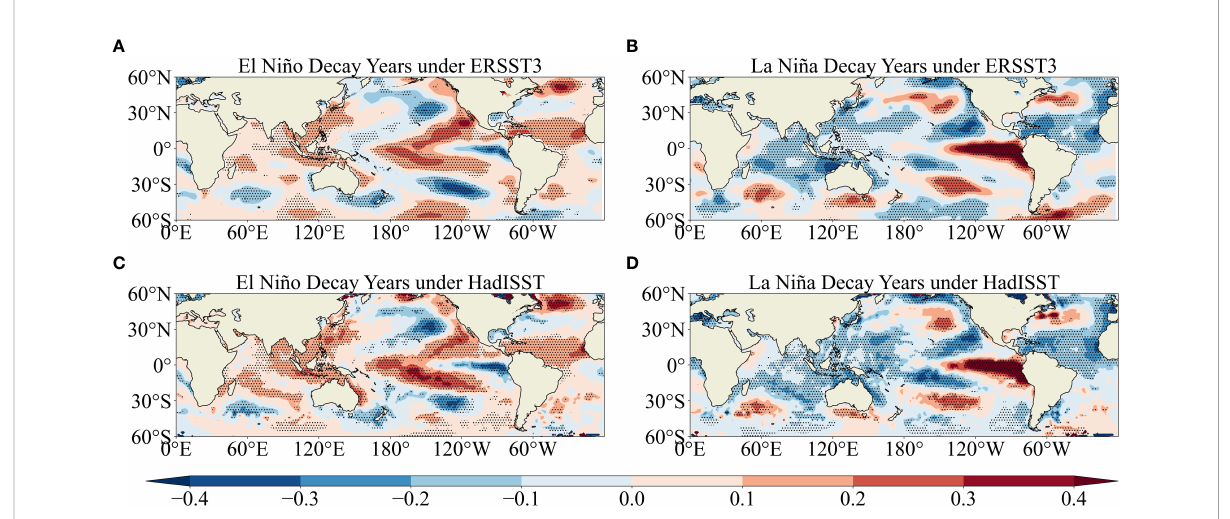
FIGURE 9 Composite SST anomalies from the ERSST3 dataset (A) during El Niño decay events and (B) La Niña decay events. (C, D) as in (A, B) but for the HadISST dataset. The dotted represent signi fi cance at the 0.05